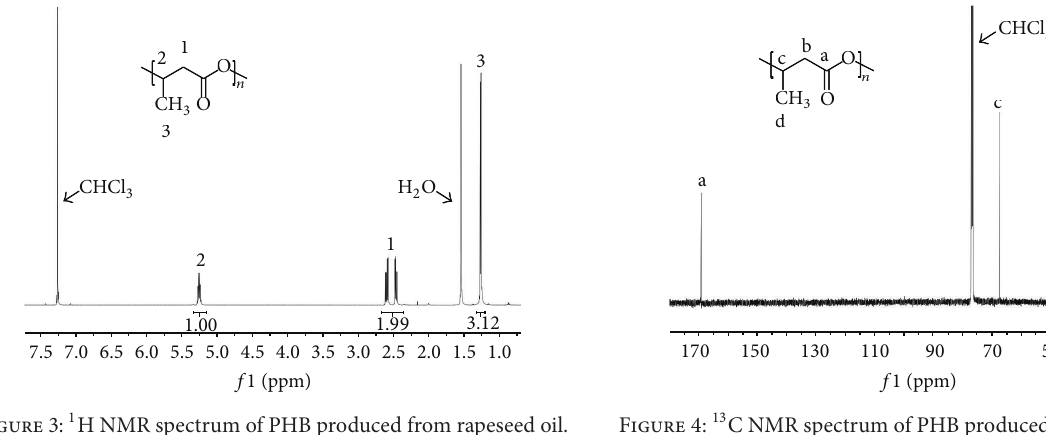
Figure 3: 1 H NMR spectrum of PHB produced from rapeseed oil. Figure 4: 13 C NMR spectrum of PHB produced from rapeseed